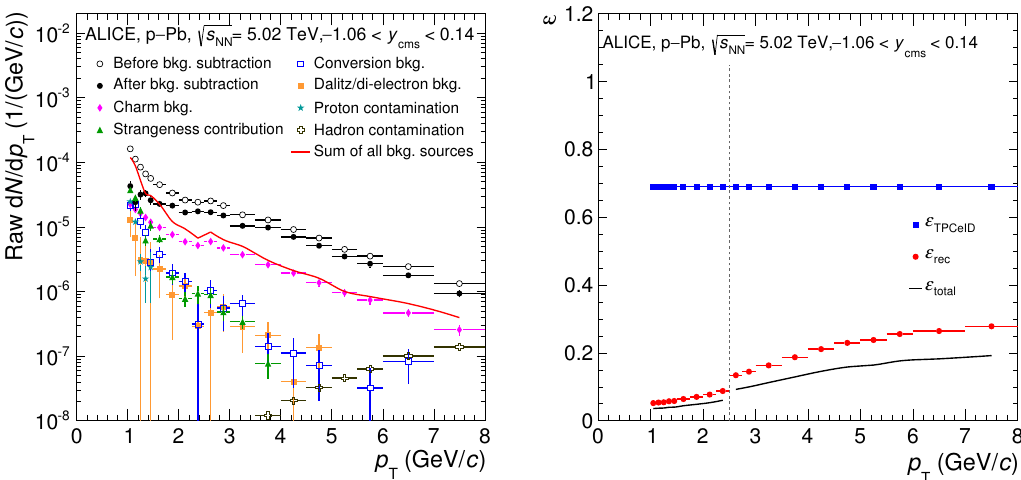
Figure 2 . (Left) Raw transverse momentum distribution of electrons after track, eID and impact parameter requirement in comparison with the proton and hadron contamination as well as electrons from the di(cid:11)erent background sources in p-Pb collisions. The error bars represent the statistical uncertainties. (Right) E(cid:14)ciencies for the p-Pb analysis as a function of transverse momentum (see text and equation 4.1 for details). The vertical dashed line indicates the switch of the eID between the TPC and TOF and TOF-only